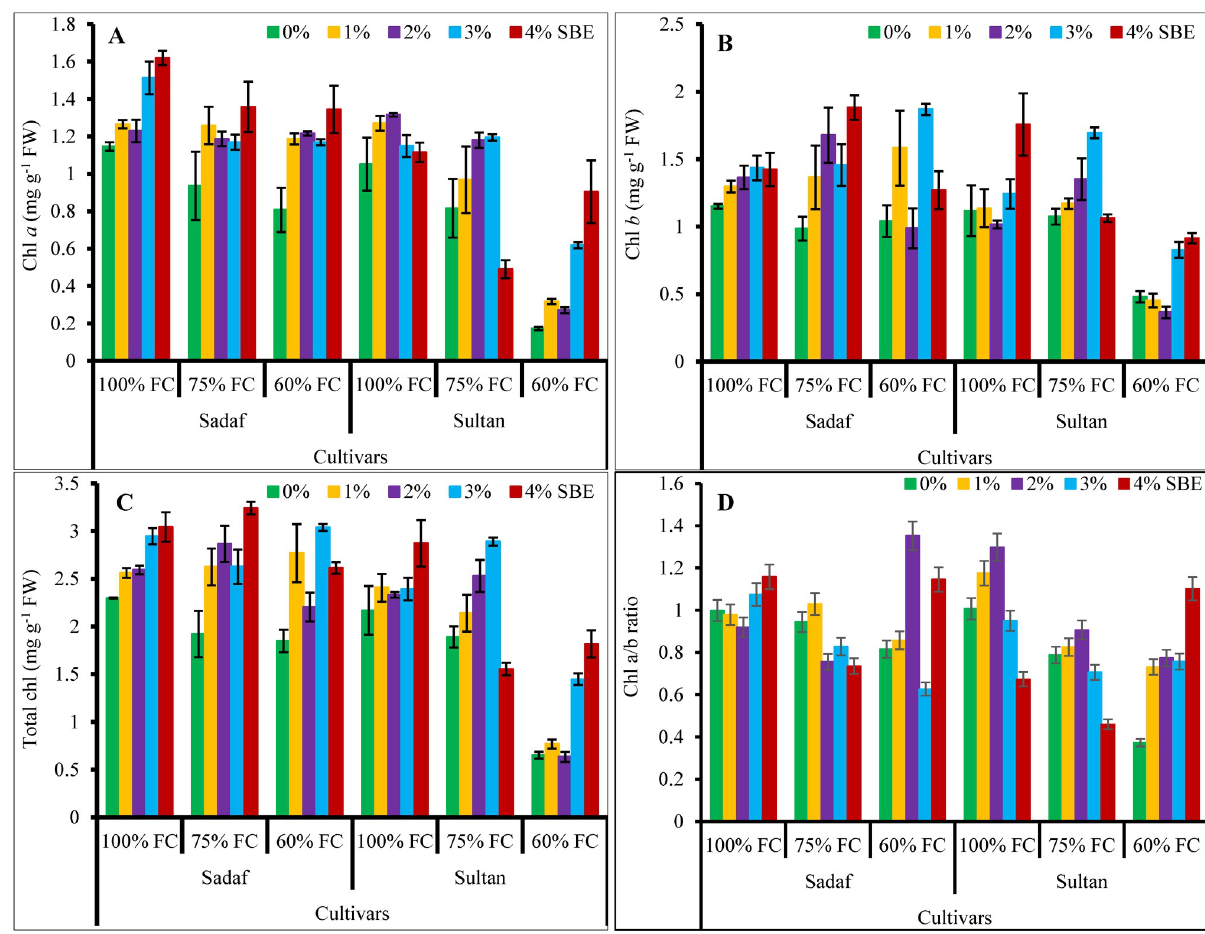
Fig 3. Restoration of chlorophyll pigments by supplementation of SBE of maize plants subjected to water-deficit stress ( n = 3; Mean ± S.E.).